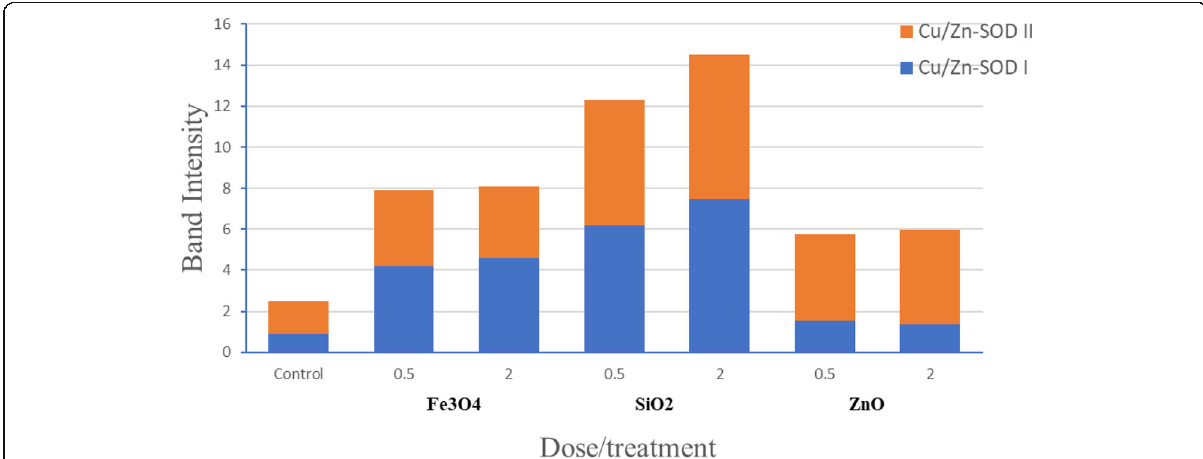
Fig. 1 Activity of SOD isoforms in 45 days old Salvadora persica callus treated with Fe 3 O 4 , SiO 2 , or ZnO nanoparticles and the control. The SOD activity was represented as relative band intensities of Cu/ZnSODI and